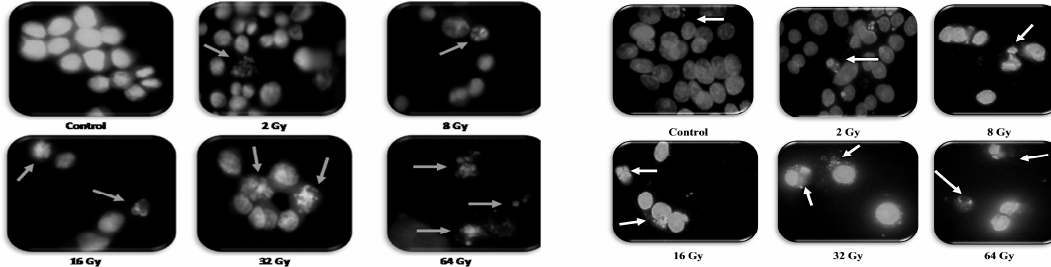
Figure 2. Representative fluorescent images of the nuclear morphology of C-4 I ( left ) and HeLa cells ( right ) in the control and all irradiated (2, 8, 16, 32 and 64 Gy) groups at 60 h post irradiation time, following DAPI staining and observed by a fluorescence microscope (X1000). Arrows represent apoptotic